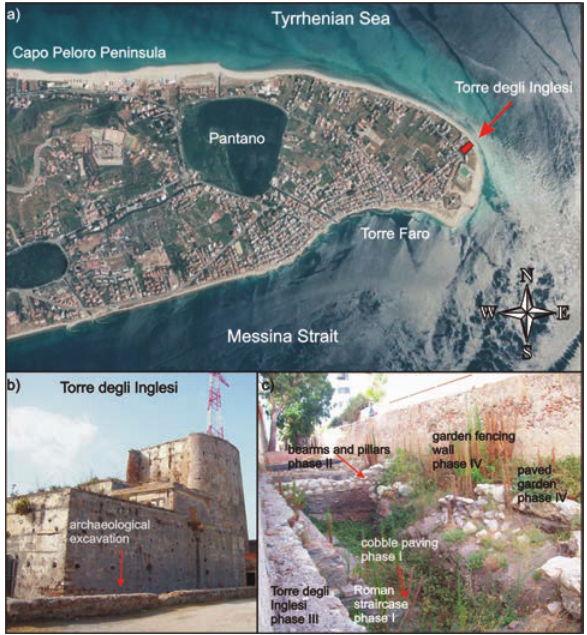
Figure 6. a) Google Earth image of Capo Peloro peninsula with the position of Torre degli Inglesi (arrow) just north of Torre Faro vil- lage that was affected by the February 6, 1783 and 1908 tsunamis. b) Torre degli Inglesi photo from NE; c) View of the archaeological excavation on the NW side of Torre degli Inglesi. The main build- ing phases (I to IV) are evidenced and it is possible to observe the rel- ative chronology [modified from Pantosti et al.